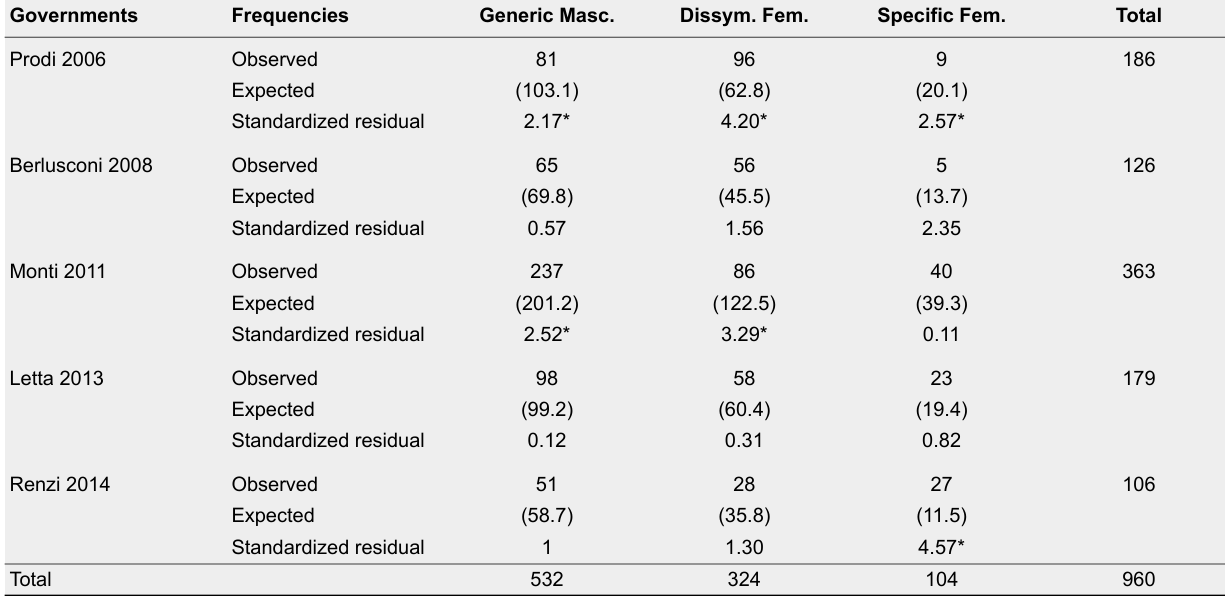
Distribution of Three Linguistic Forms by Five